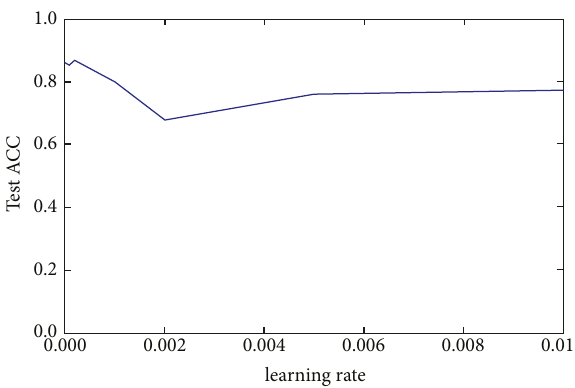
Figure 10: Correct rate of test set under different learning rates.